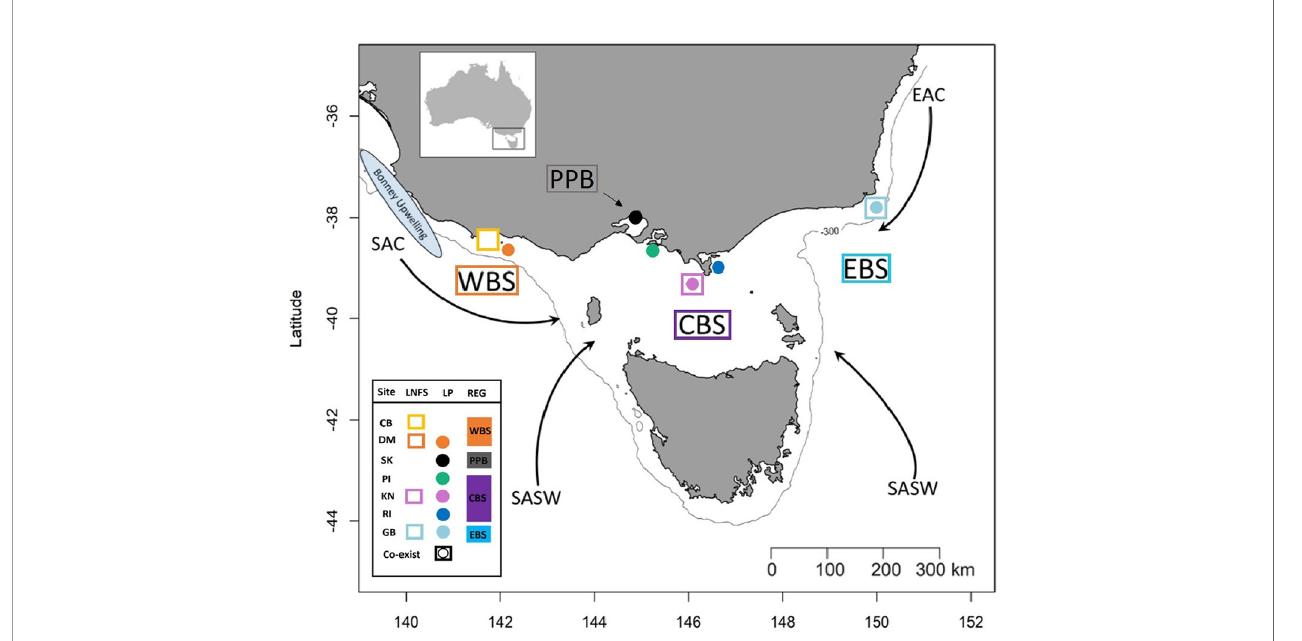
FIGURE 1 | Simpli fi ed representation of the four sampling regions and the major water masses in fl uencing those regions. Western Bass Strait (WBS); Port Phillip Bay (PPB); Central Bass Strait (CBS); Eastern Bass Strait (EBS); Cape Bridgewater (CB); Deen Maar Island (DM); St. Kilda (SK); Phillip Island (PI); Kanowna Island (KN); Rabbit Island (RI); Gabo Island (GB); South Australian Current (SAC); Sub-Antarctic Surface Water (SASW); and East Australian Current (EAC) from Sandery and Kämpf (2007). Circles indicate sampled penguin colonies, squares represent sample sites of scats of long-nosed fur seals and squares with circles represent locations where both species co-exist. The solid line indicates the location of the 300m